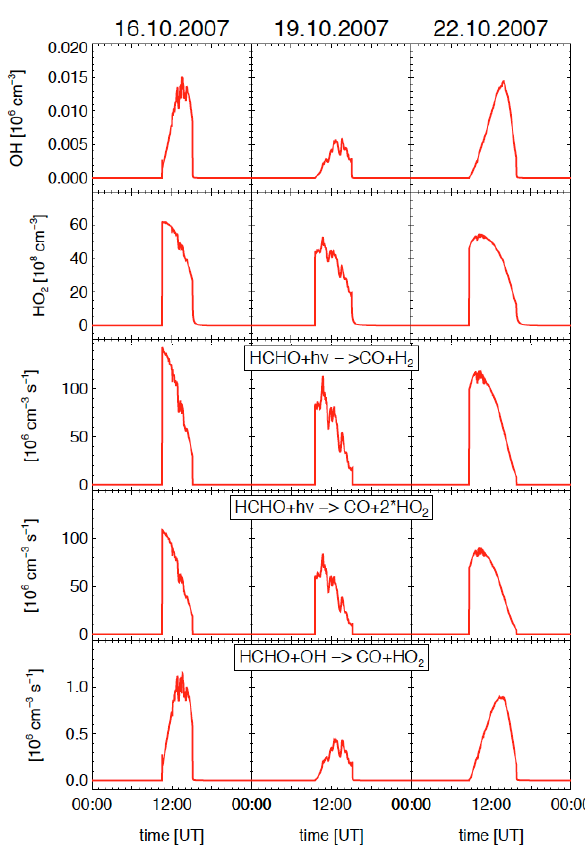
Fig. 5. Modelled OH and HO 2 mixing ratios in the SAPHIR cham- ber, and the calculated removal rates of HCHO via the two photol- ysis channels and reaction with OH. Removal by OH accounts for < 0.5% of the total removal and can be